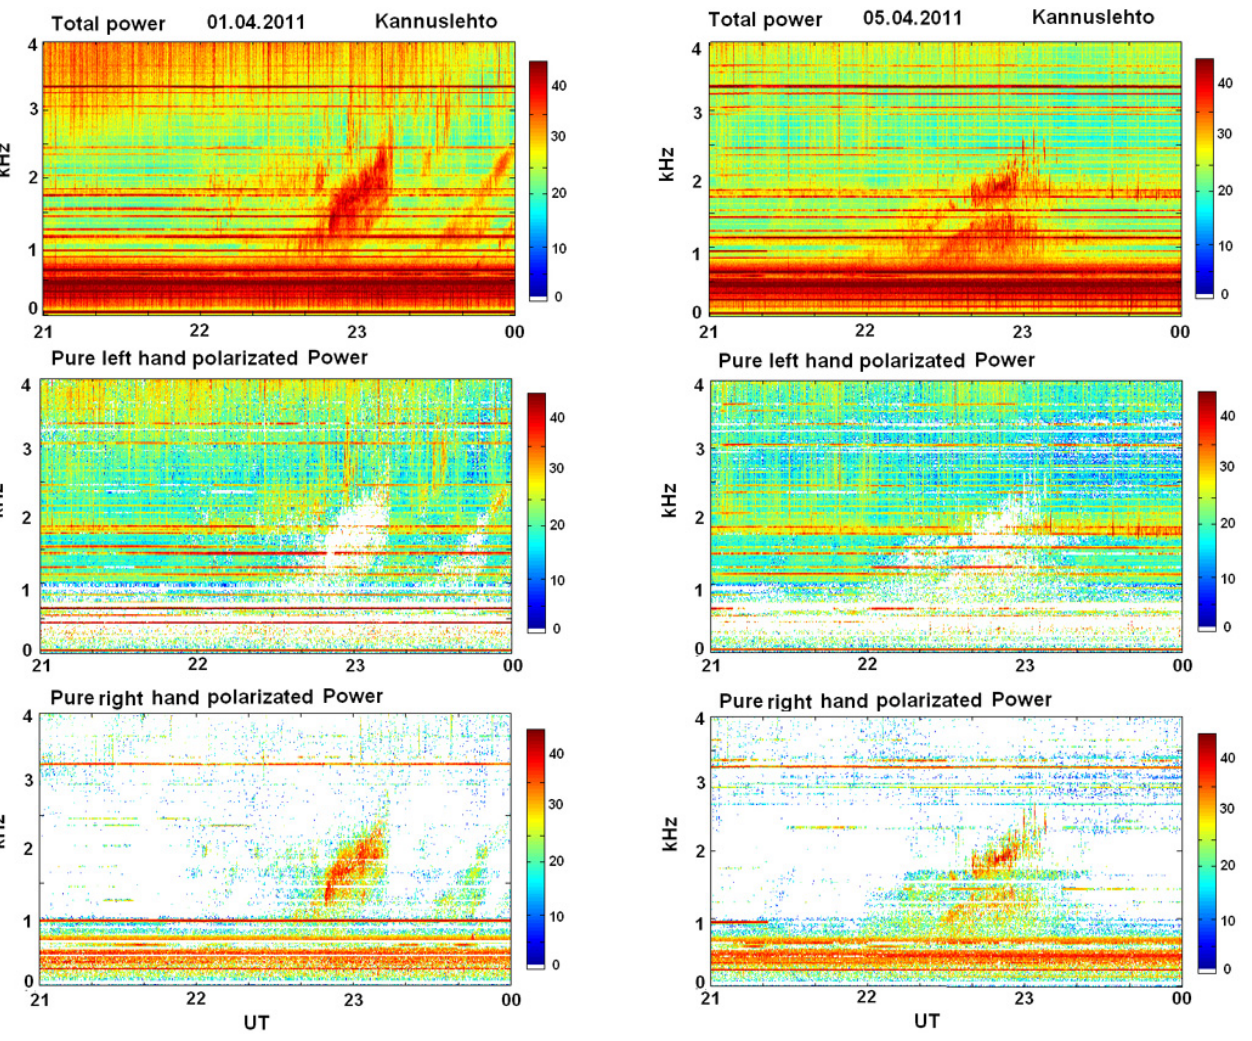
Fig. 5. Spectrograms of the chorus events on 1 April (left) and 5 April (right) 2011: total power, left-hand and right-hand polarized wave